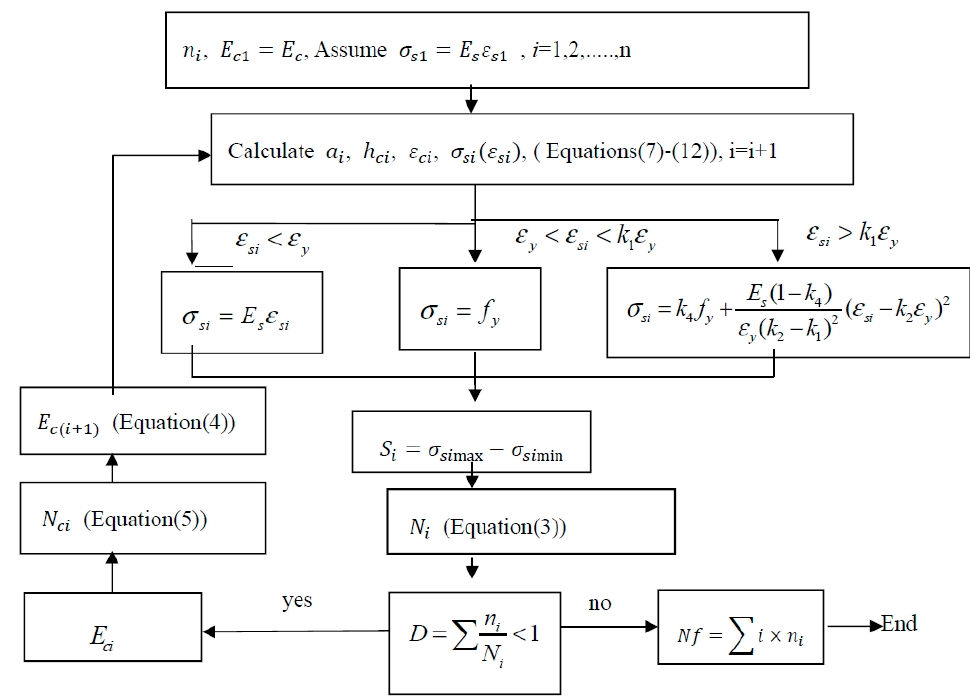
Figure 3. Procedure for calculating the fatigue life N f .